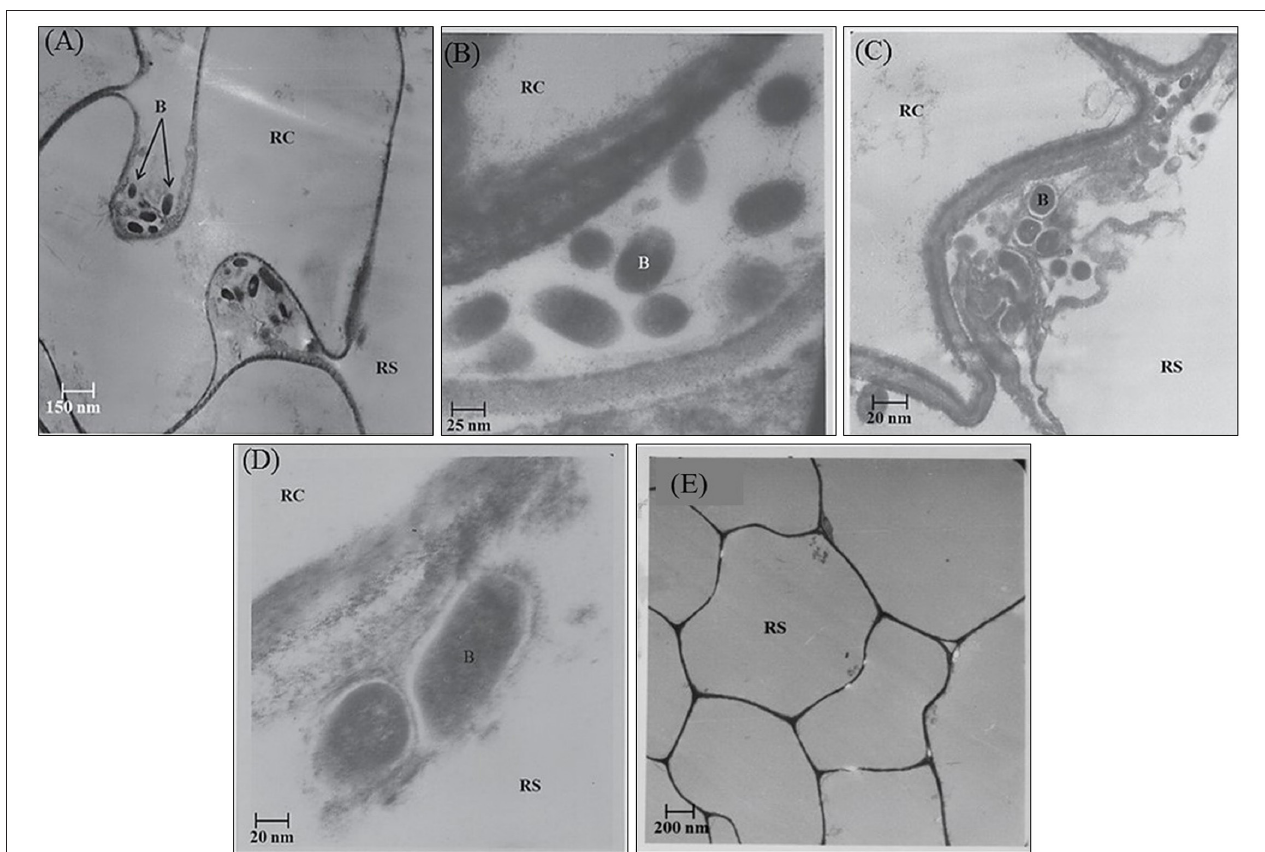
FIGURE 3 | Electron-micrograph of ultrathin sections of root inoculated with Azospirillum sp. TN09 after 30 days. RC = Root cell, B = Bacterium and RS = Rhizosphere. Cells of Azospirillum sp. TN09 form micro-colonies among root cells forming clusters of bacterial cells (A,B) . These multicellular aggregates on root surface were also embedded within the extracellular matrix showing strong adhesion with the roots of potato plants (C,D) and in uninoculated control plants no microbial cells or clusters were observed (E) .